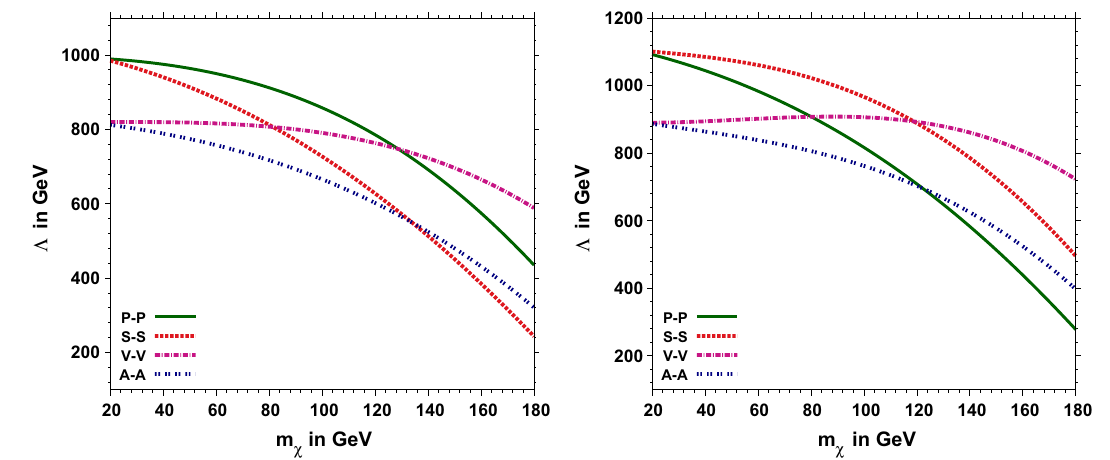
Fig. 9 99% confidence level contours in the m χ and Λ plane from the combined χ 2 analyses of all the three visible modes at for the collider parameter choice given in the first and second column of Table 1. The contours at the left correspond to the unpolarised beam